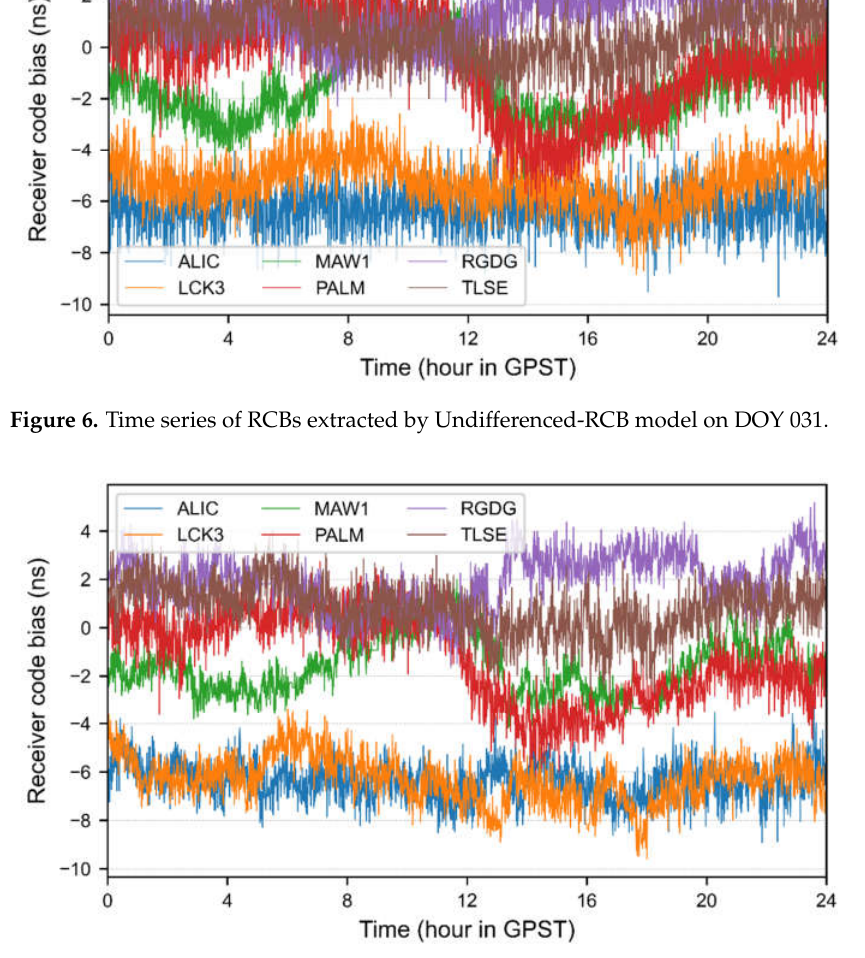
Figure 7. Time series of RCBs extracted by Undifferenced-SRCB model on DOY 031.